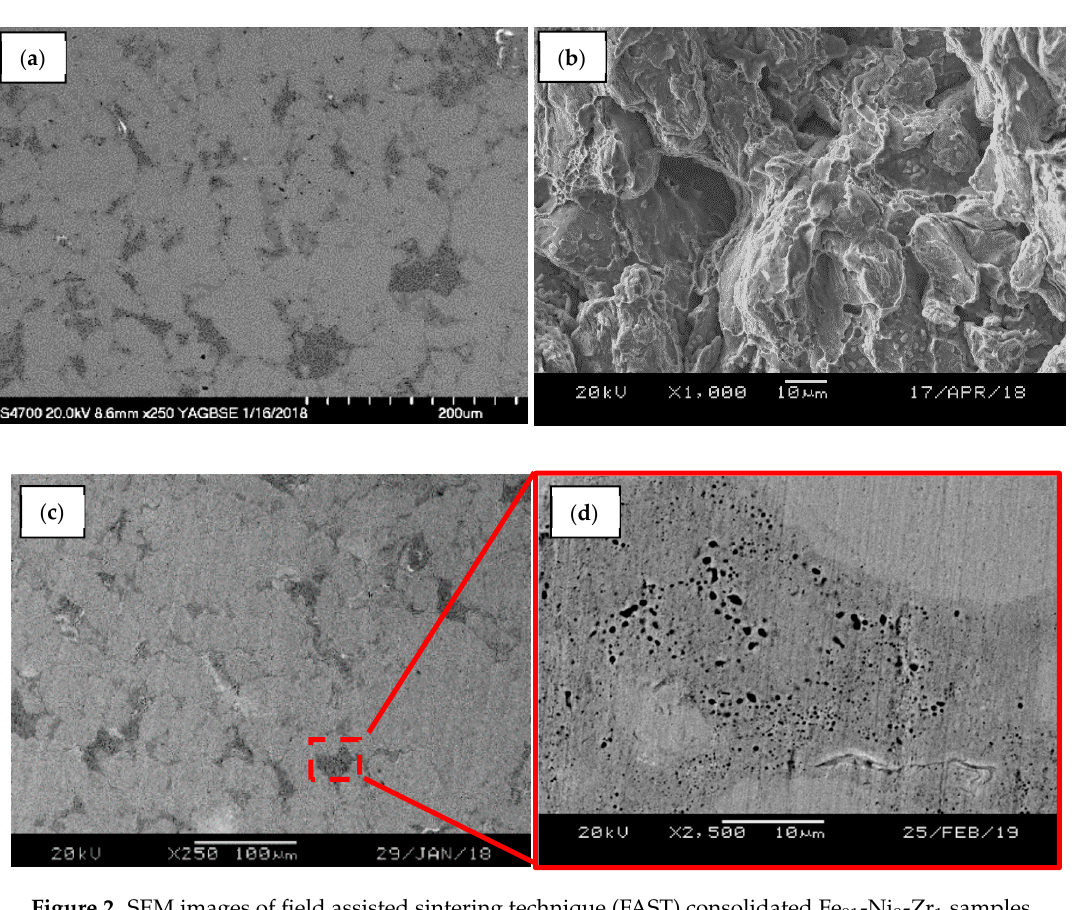
Figure 2. SEM images of field assisted sintering technique (FAST) consolidated Fe 91 -Ni 8 -Zr 1 samples under the following processing conditions and preparation type: ( a ) 750 °C-30 min—polished, ( b ) 750 °C-30 min—fracture surface ( c , d ) 750 °C-60 min—polished.